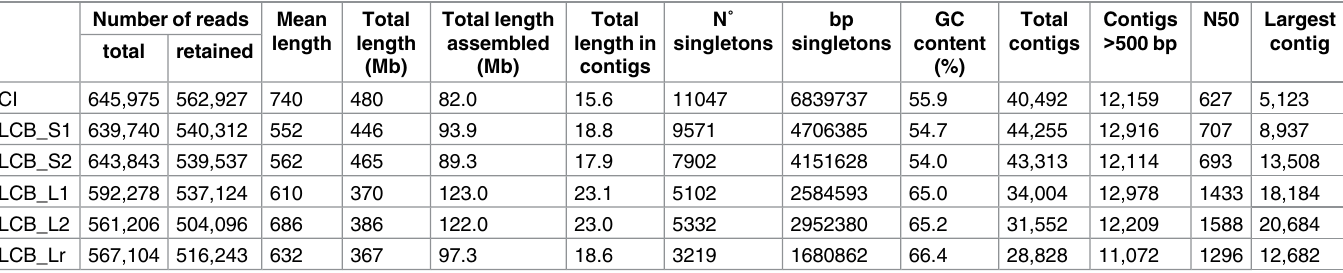
Table 3. Summaryof raw and assembleddata obtained in the six 454 pyrosequencing runs. Number of